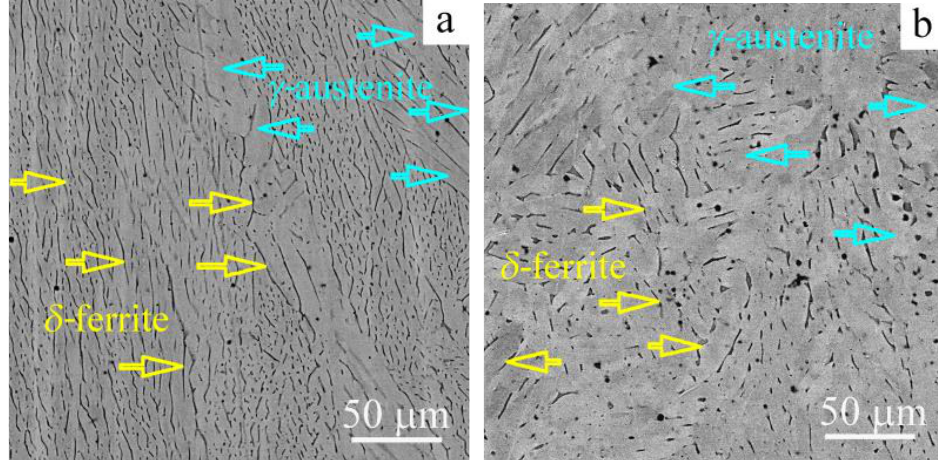
Figure 1. Typical SEM images of the microstructure in AM ( a ) and AM + SST ( b ) samples. Dark gray areas are δ -ferrite lamellae (some of them are marked by yellow arrows) in the austenitic matrix (light grey areas are marked by turquoise arrows). The applied magnification is ×200.